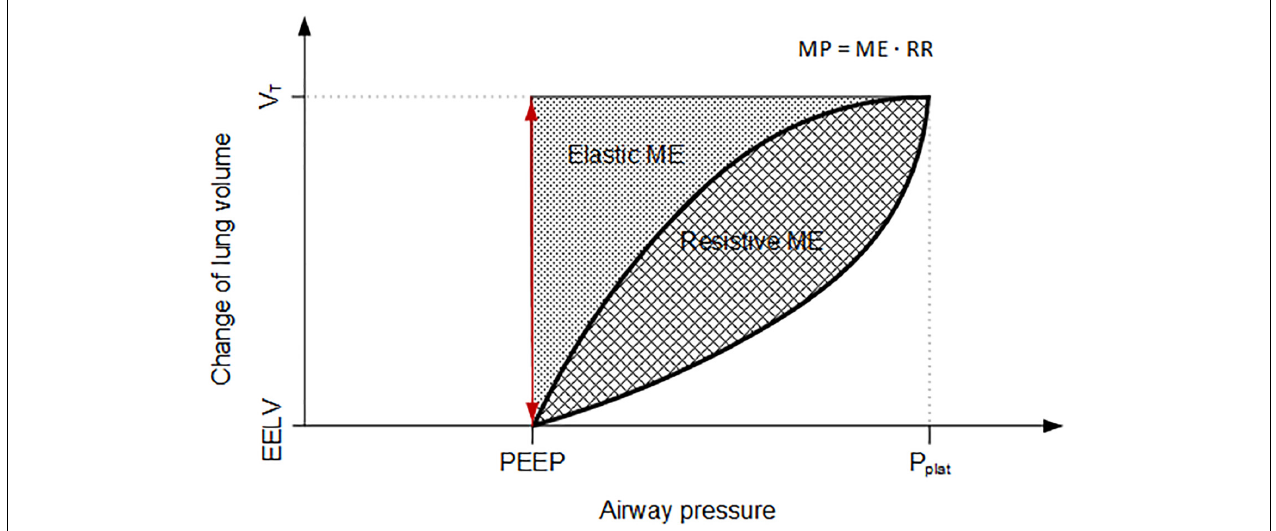
FIGURE 2 | Schematic pressure–volume curve for calculation of mechanical energy. Schematic visualization of changing lung volume and pressure per respiratory cycle, constituting the pressure–volume curve. MP, mechanical power; ME, mechanical energy; RR, respiratory rate; PEEP, positive end-expiratory pressure; P plat , plateau airway pressure; V T , tidal volume; EELV, end-expiratory lung volume.